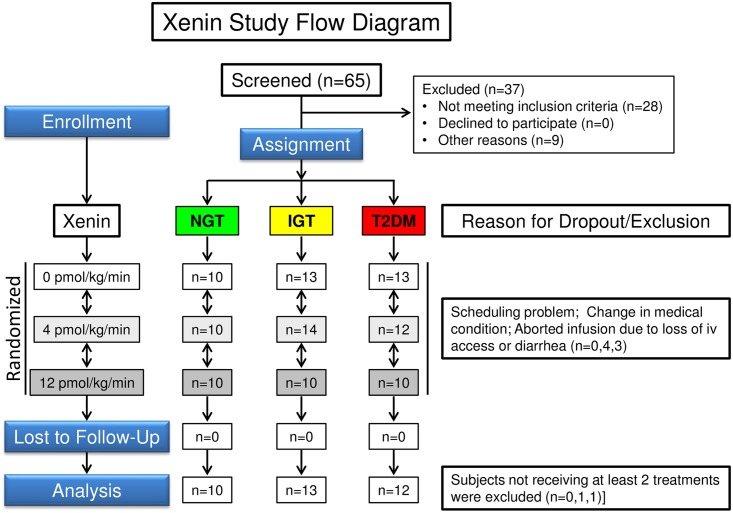
Flow diagram for xenin study.Diagram is for a non-randomized crossover study with different doses of xenin-25 in humans with NGT, IGT, and T2DM.